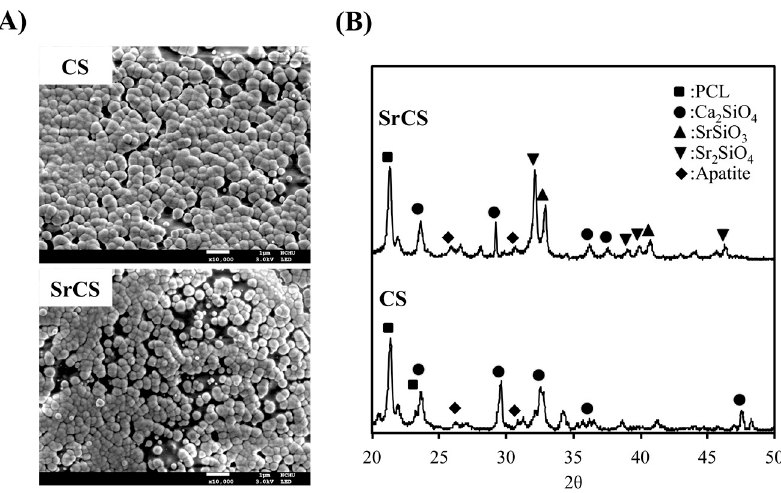
Figure 5. ( A ) Surface SEM images and ( B ) X-ray diffraction patterns of CS and SrCS scaffold after immersed in SBF for 3 days. Scale bar: 1 µm.